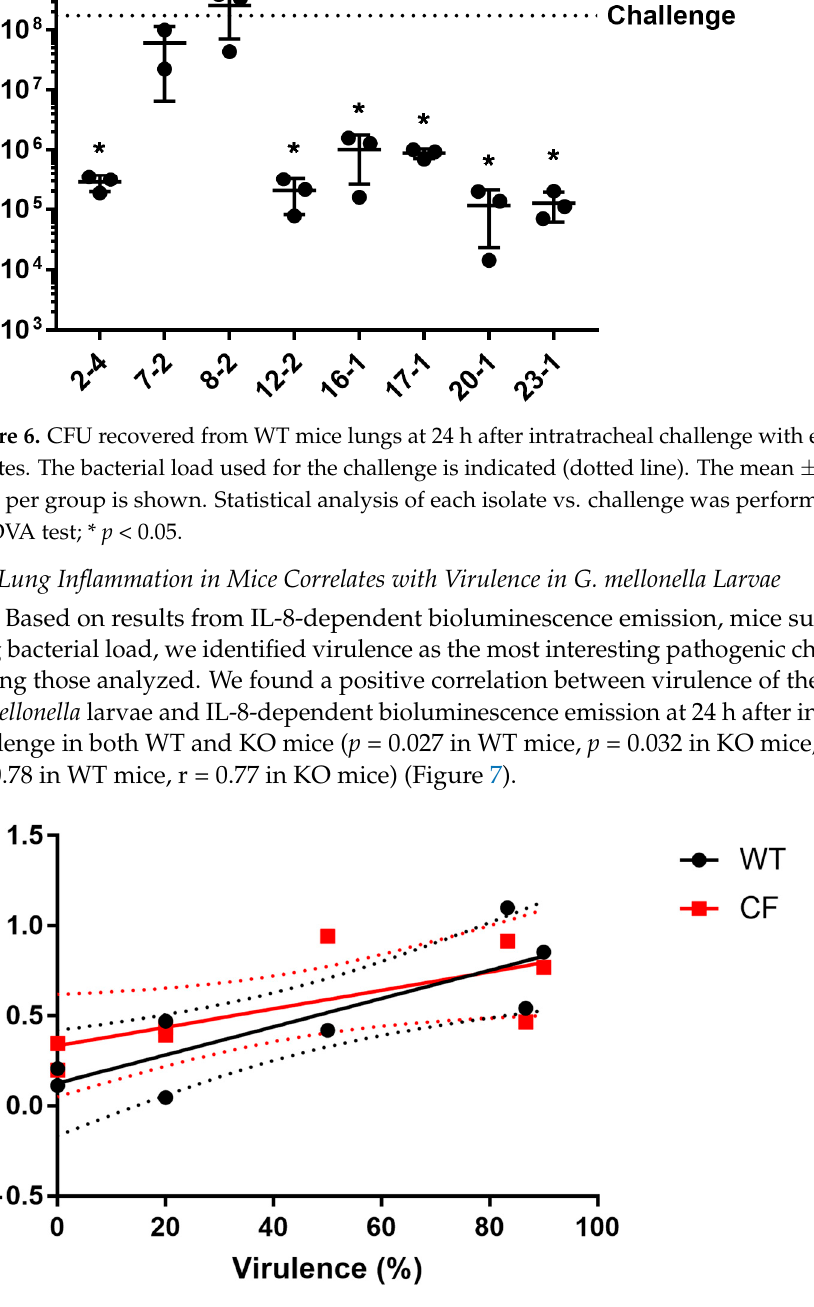
Figure 5. CFU recovered from WT mice lungs at 24 h after intratracheal challenge with clinical isolates showing ( a ) high–medium vs. low–no virulence in G. mellonella larvae, ( b ) high–medium vs. low–no cytotoxicity in human bronchial epithelial cells, ( c ) high–medium vs. low–no bio fi lm formation. Each value represents the mean of three animals challenged with each isolate. The median ± interquartile range of 12 mice per group is shown.